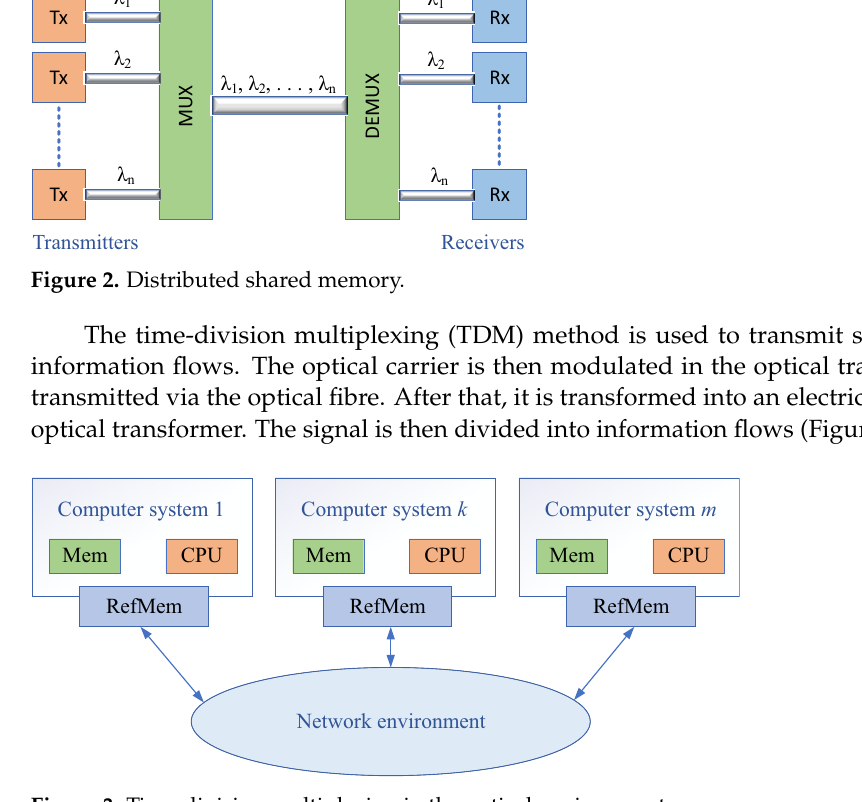
Figure 3. Time-division multiplexing in the optical